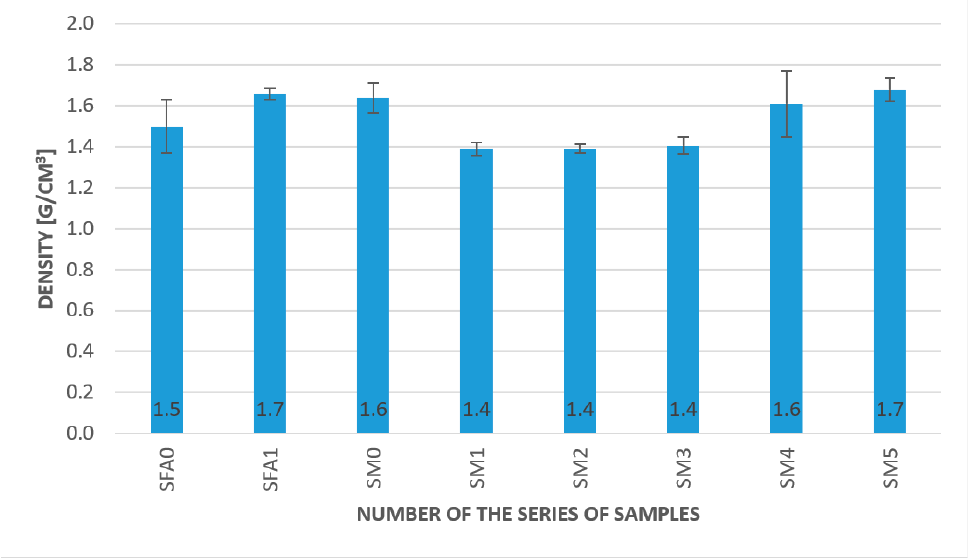
Figure 5. Density test result.